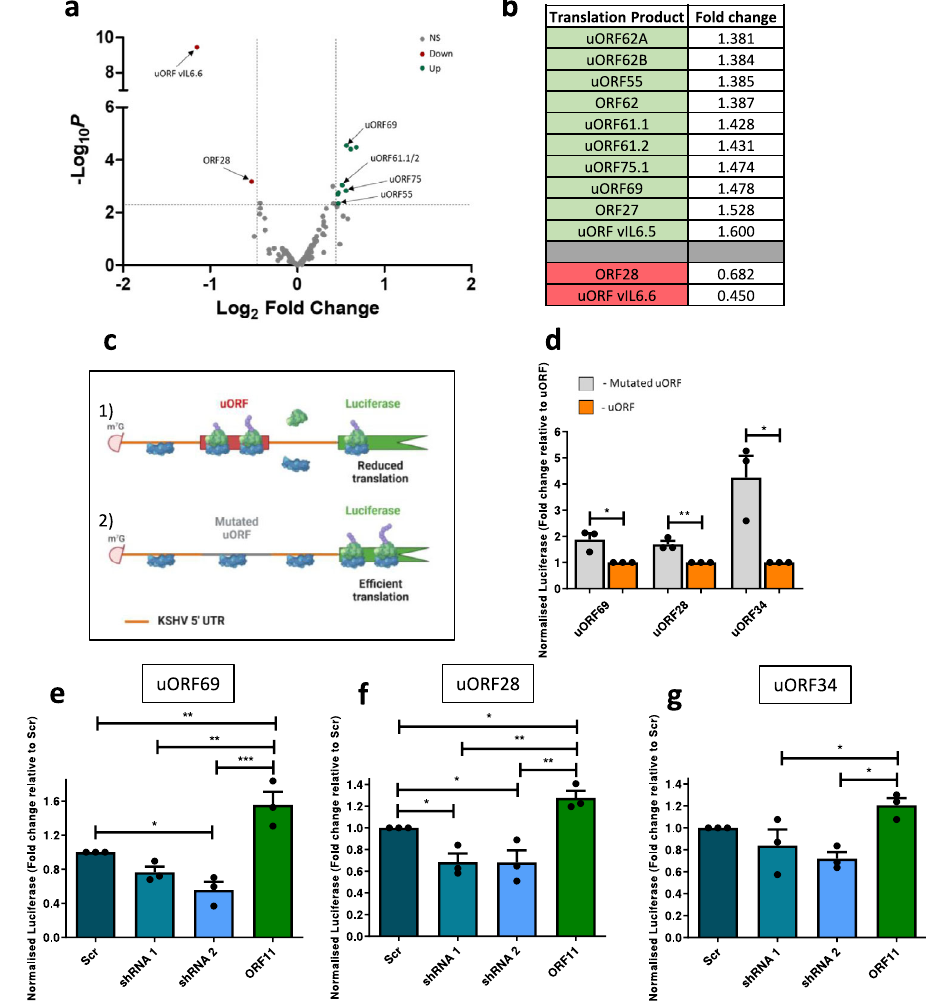
Fig. 5 | ORF11 and BUD23 are required for the ef fi cient translation of key late lyticKSHV mRNAs which contain uORFs. a Changes in translationalef fi ciency of viralgenescalculatedforlibrariesoriginatingfromTRExBCBL1-Rtacellsexpressing a Scr shRNA compared to shRNA 1 targeting BUD23 at 36h post KSHV lytic reac- tivation. A false discovery rate was set at <0.005 and fold change threshold set at ±0.45 (log2). Volcano plot representation of all KSHV gene translational ef fi ciency changes ( n =2 biologically independent samples). b Table of all KSHV genes with signi fi cantly changed translational ef fi ciencies >± 0.45 (log 2 ). c Schematic of luci- ferase reporter assays with upstream KSHV mRNA 5' UTRs containing (1) uORFs or (2) with the uORF start codon mutated in HEK 293T cells. d Normalised luciferase intensity was quanti fi ed from luciferase reported plasmids containing uORFs